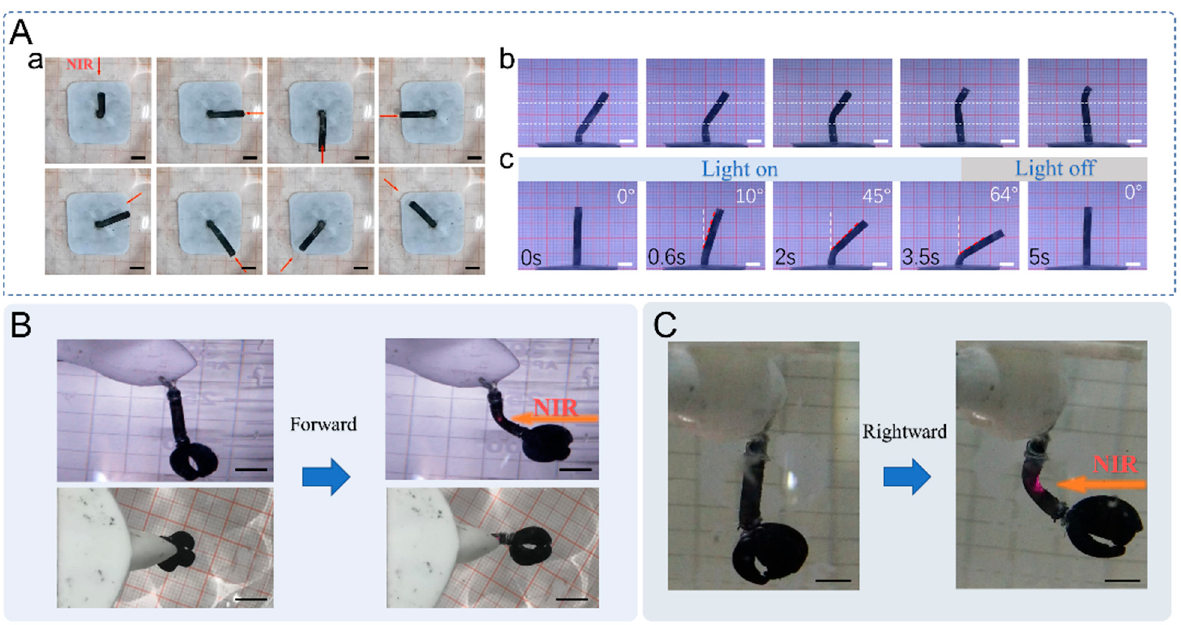
Figure 5. ( A ) NIR laser t-driven performance of the multi-degree-of-freedom arm. ( a ) The NIR laser drives the bionic arm to rotate 360°. ( b ) The NIR laser can drive the bionic arm to deform at any position. ( c ) The effect of light duration on the amount of bending deformation of the bionic arm. ( B ) The bionic arm drives the micromanipulator to achieve a forward bending motion. ( C ) The bionic arm drives the micromanipulator to achieve a rightward bending motion (Scale bar is 5 mm).